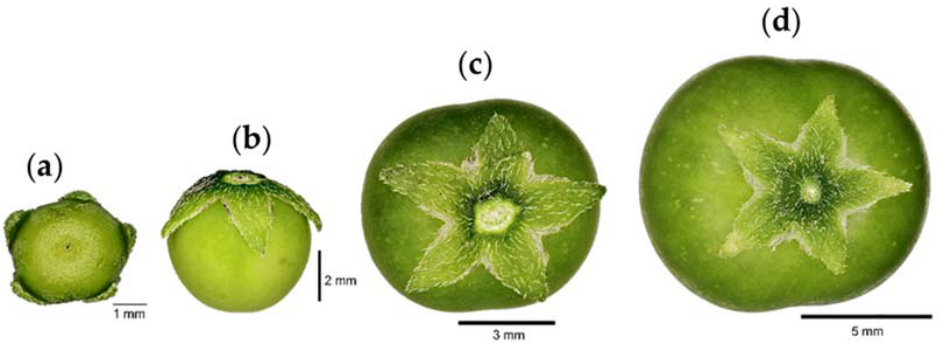
Figure 12. Fruit of slender nightshade plants ( Solanum nigrescens ) with the 5 ( a ), 20 ( b ), 70 ( c ), and 100% ( d ) of their final size. Photos by Jorge Manuel Valdez-Carrasco.